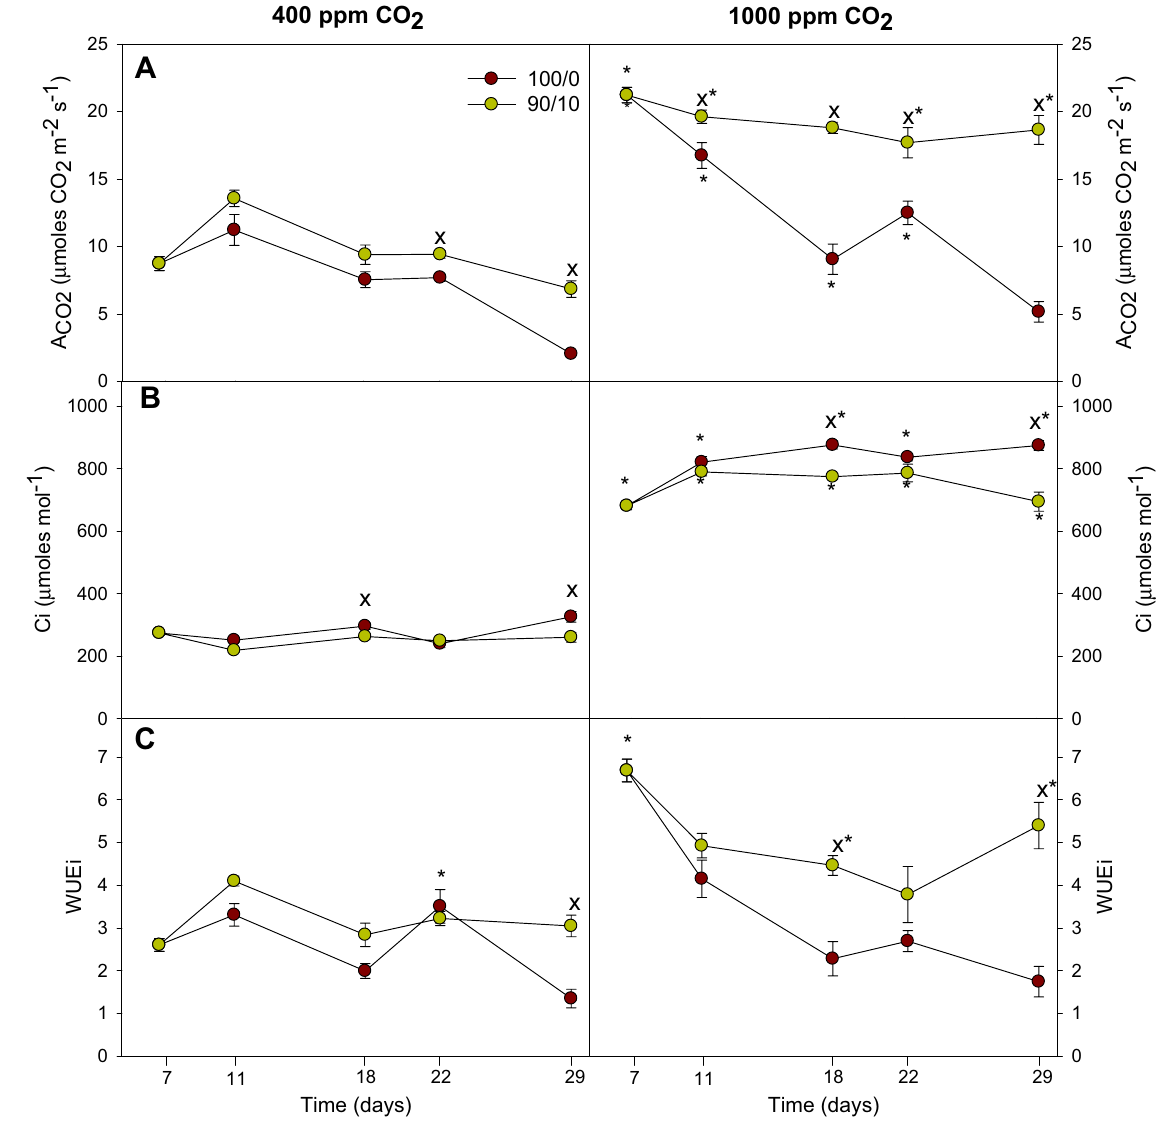
Figure 1. Effect of N forms (100% NO 3 − and 90% NO 3 − /10% NH 4 + combined) under an eCO 2 on cucumber plants: ( A ) net photosynthesis rate (A CO2 ); ( B ) internal CO 2 concentration (Ci); and ( C ) instantaneous water- use efficiency (WUEi). Data are means ± SE of six plants. * denotes significant differences ( P < 0.05) between plants in different CO 2 treatments, with the same nitrogen treatment; X denotes significant differences ( P < 0.05) between nitrogen treatments for the same CO 2